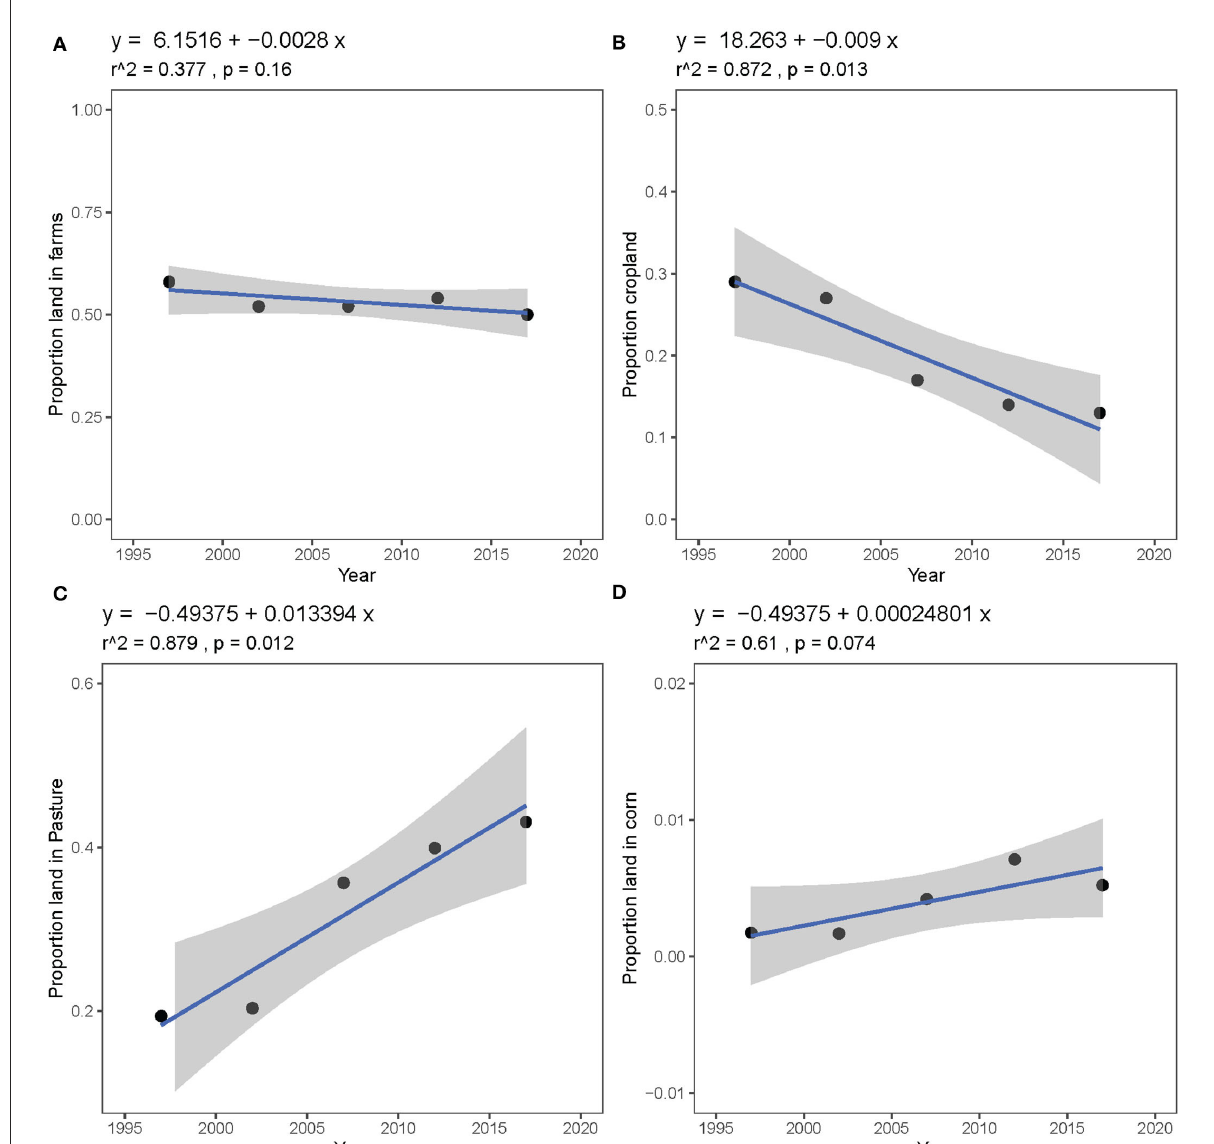
FIGURE6 Trends in land use in Camden, Dallas, and Laclede Counties between 1997 and 2017 as reported to the United States Census of Agriculture: (A) proportion of total land area in farms, (B) proportion of farm land planted in crops, (C) proportion of farm land used as pasture or rangeland, and (D) proportion of farm land planted in